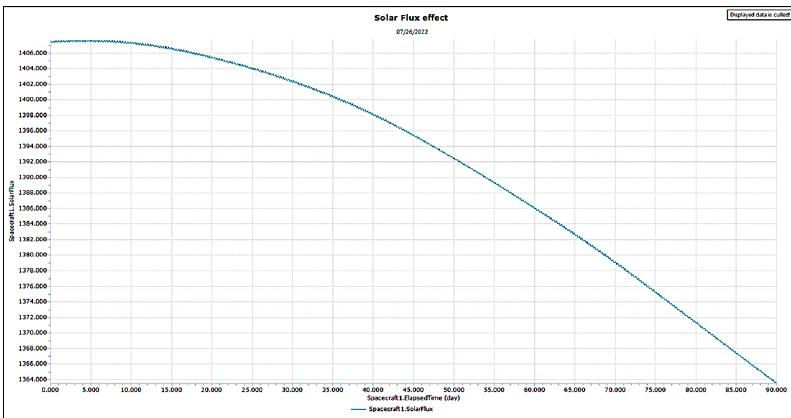
Figure 8. Apogee and perigee height variation for 90 days under Drag-SRP.